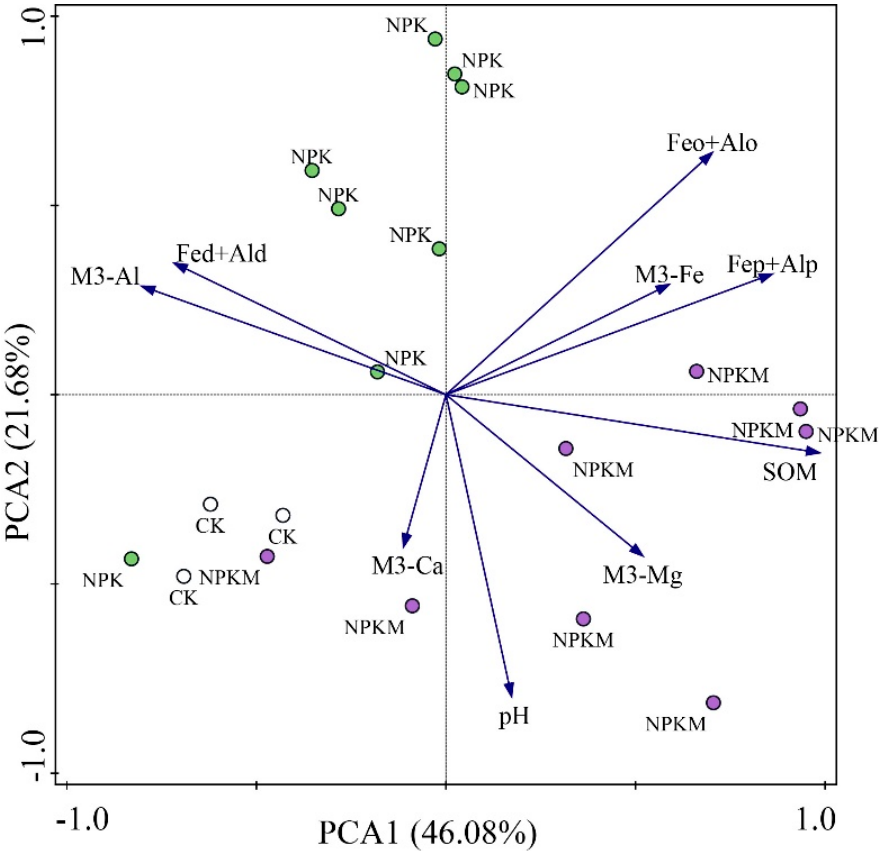
Figure A3. Correlation between soil properties under long-term different fertilization regimes with principal components analysis (PCA). The sum of the first two principal components (PC) of the soil properties accounted for 67.8% of the variance. CK, no fertilizer input; NPK treatment, applying N, P, K fertilizer; NPKM treatment, applying NPK and manure (pig manure from 1990 to 2004, and cattle manure from 2005 to 2018). Loadings for PC1 were dominated by SOM (0.47), M3-Fe (0.33), M3-Mg (0.27), M3-Al ( − 0.39), Fed + Ald ( − 0.38), Fep + Alp (0.44), whereas, loadings for PC2 were dominated by pH ( − 0.63), Feo + Alo (0.38) and M3-Ca ( − 0.39). SOM, soil organic matter; Fe d and Al d , crystalline iron and aluminum oxide; Al o and Fe o , amorphous Al and Fe oxide; Al p and Fe p , organic-bound iron and alumina oxide. M3-Ca, M3-Mg, M3-Fe, and M3-Al were Ca, Mg, Fe, and Al extracted by Mehlich-3 extraction. Table A1. The proportion of P fraction determined by integration of P-NMR signals of the studied soil under long-term field trial in Mollisol.